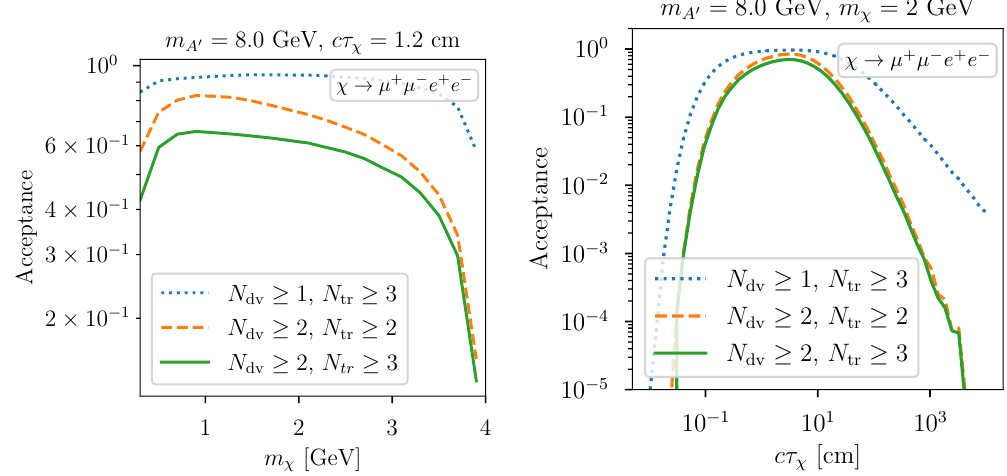
Figure 3 . Slices of the event acceptance probability for scalar LLPs χ decaying to e + e − µ + µ − for dark photon production with m function of the LLP mass for cτ